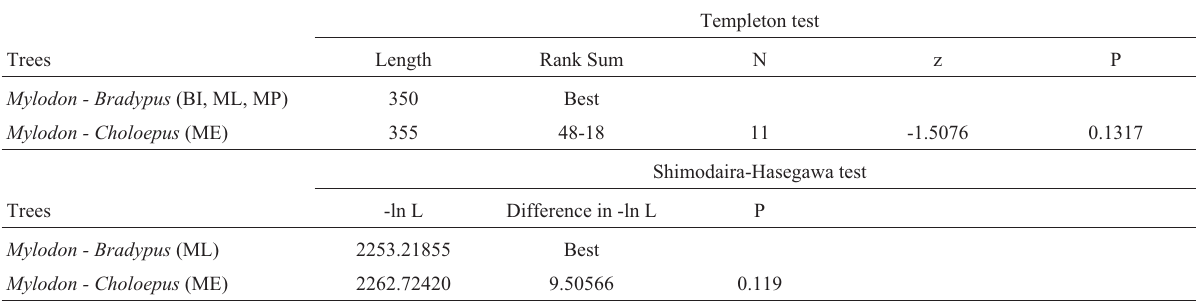
Table 2 - The relationships of Mylodon darwinii as shown by alternative 16S phylogenetic